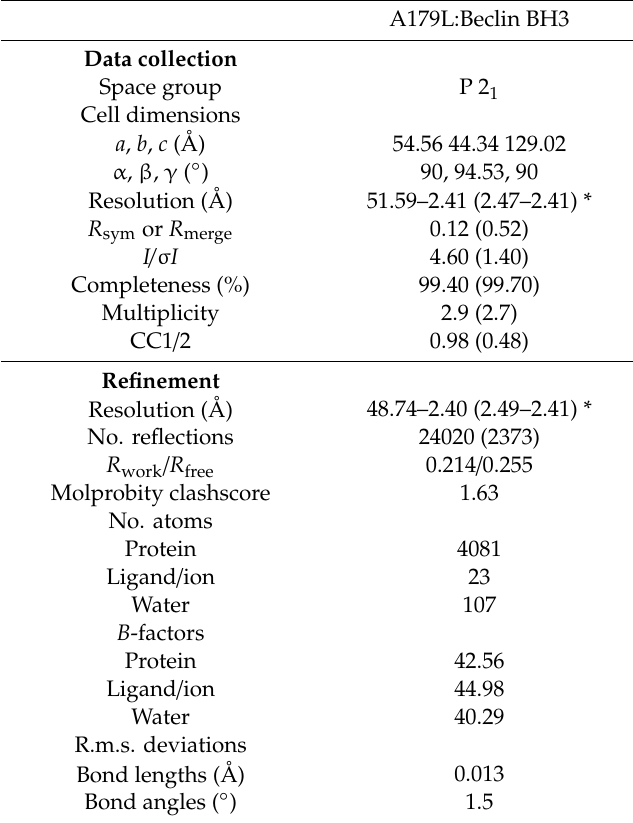
Table 1. Crystallographic data collection and refinement